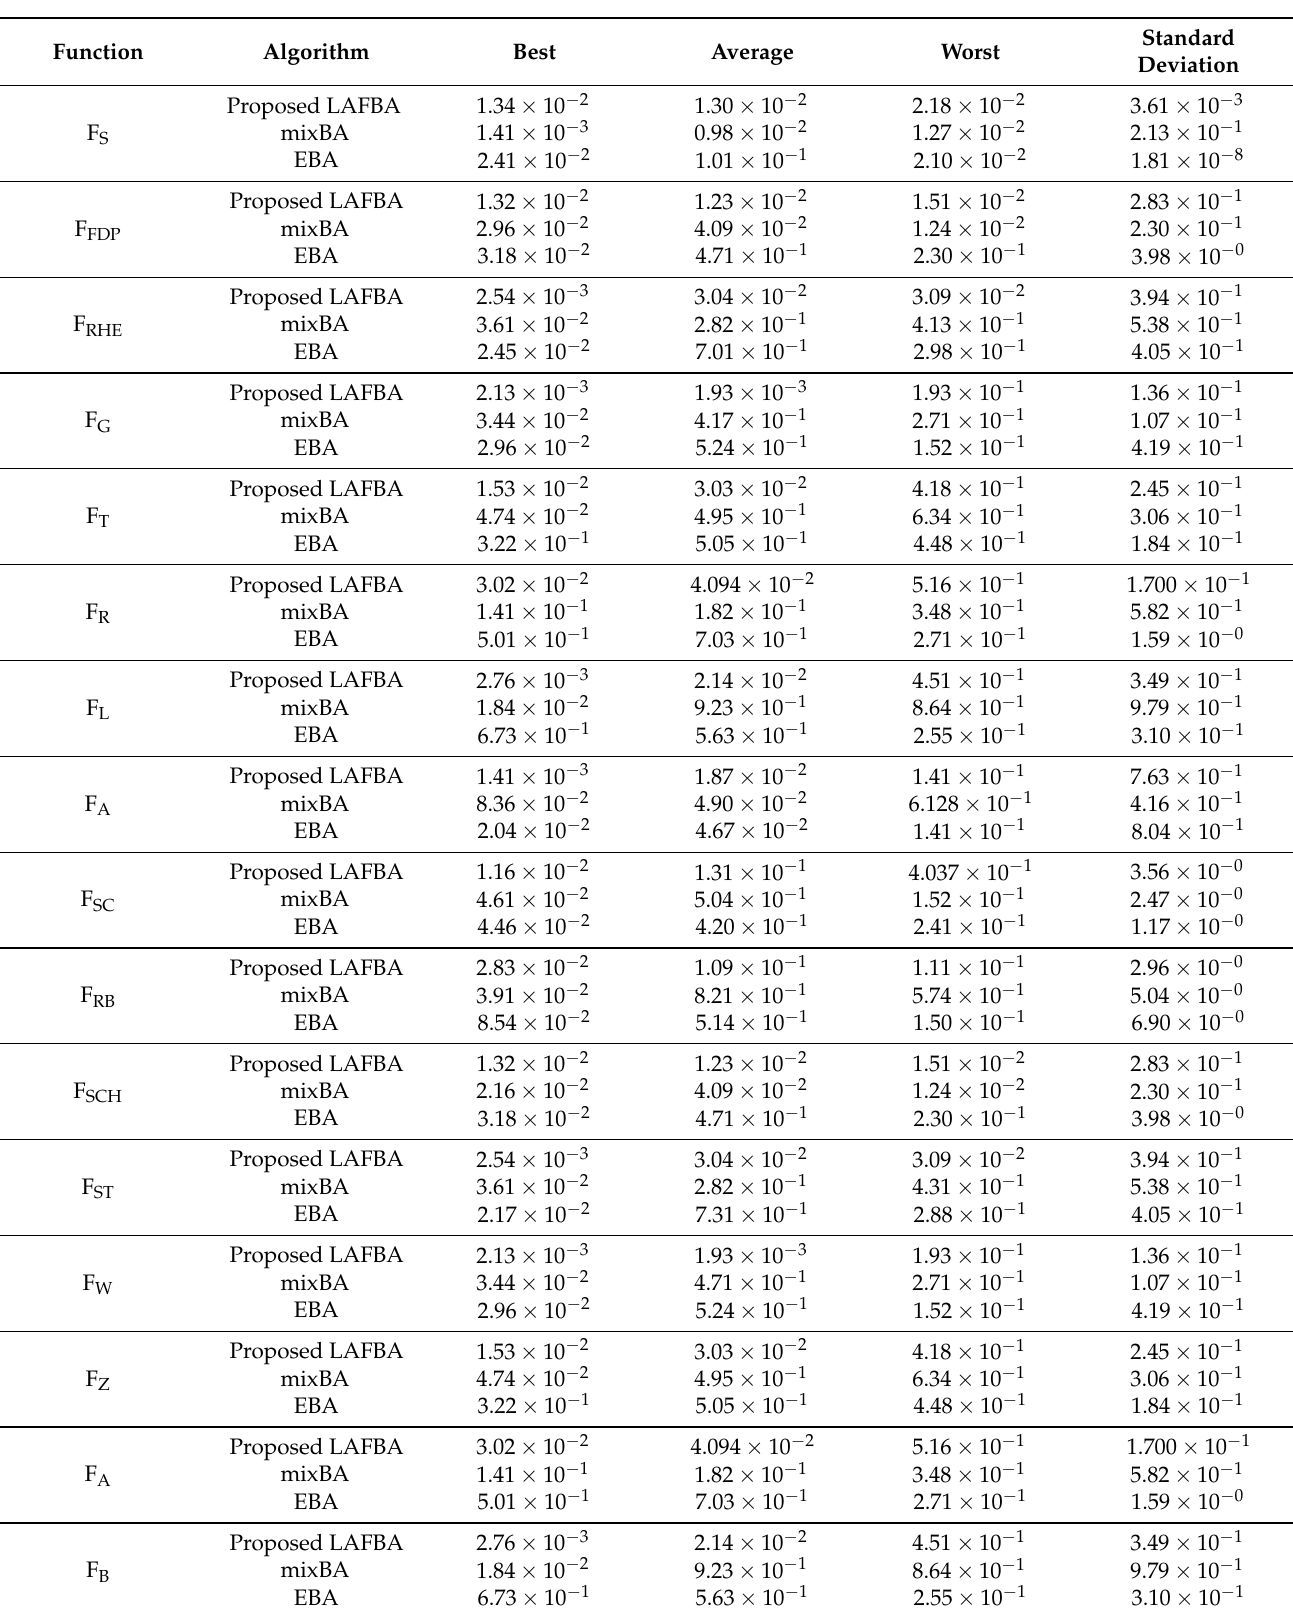
Table 1. Comparison of average fitness values of proposed LAFBA algorithm with mixBA and EBA